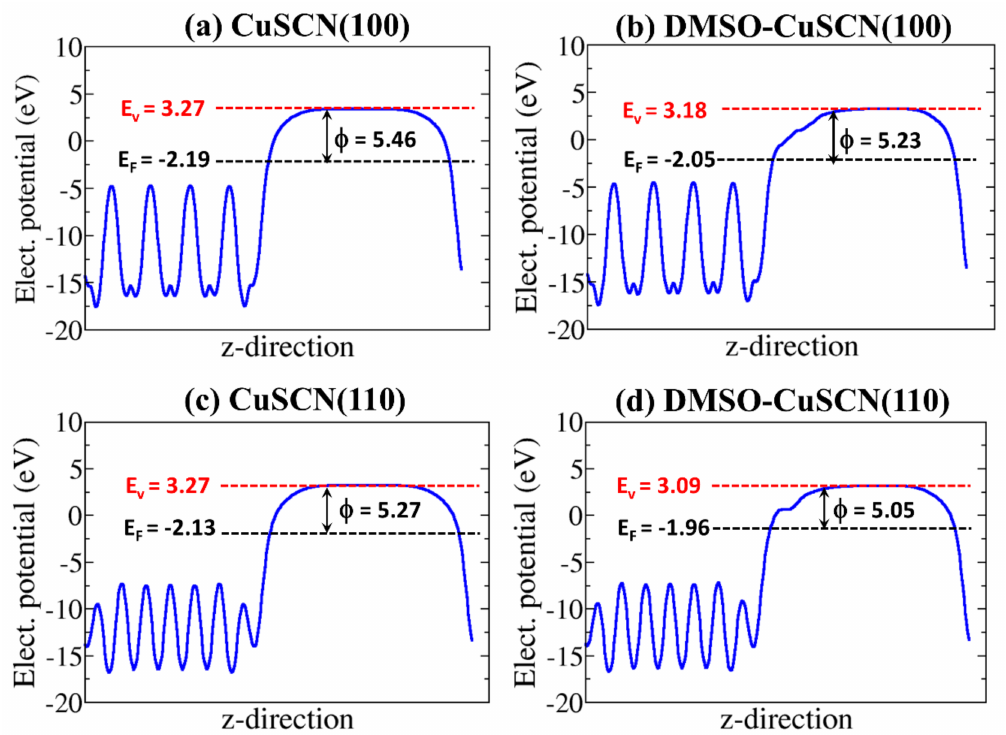
Figure 7. The averaged electrostatic potentials for ( a ) naked CuSCN (100), ( b ) DMSO-covered CuSCN (100), ( c ) naked CuSCN (110), and ( d ) DMSO-covered CuSCN (110) surfaces. Red dashed line = vacuum level ( E vac ), black dashed line = Fermi level (E F ), and Φ = work